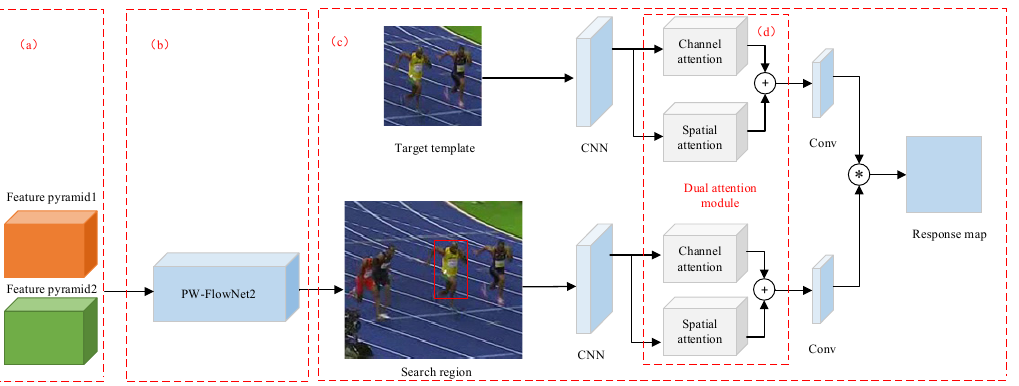
Figure 1. Complete Flow Chart of SiamFP Algorithm. (a) denotes feature pyramid extractor. (b) denotes optical flow network. (c) denotes siamese network. (d) denotes attention network.